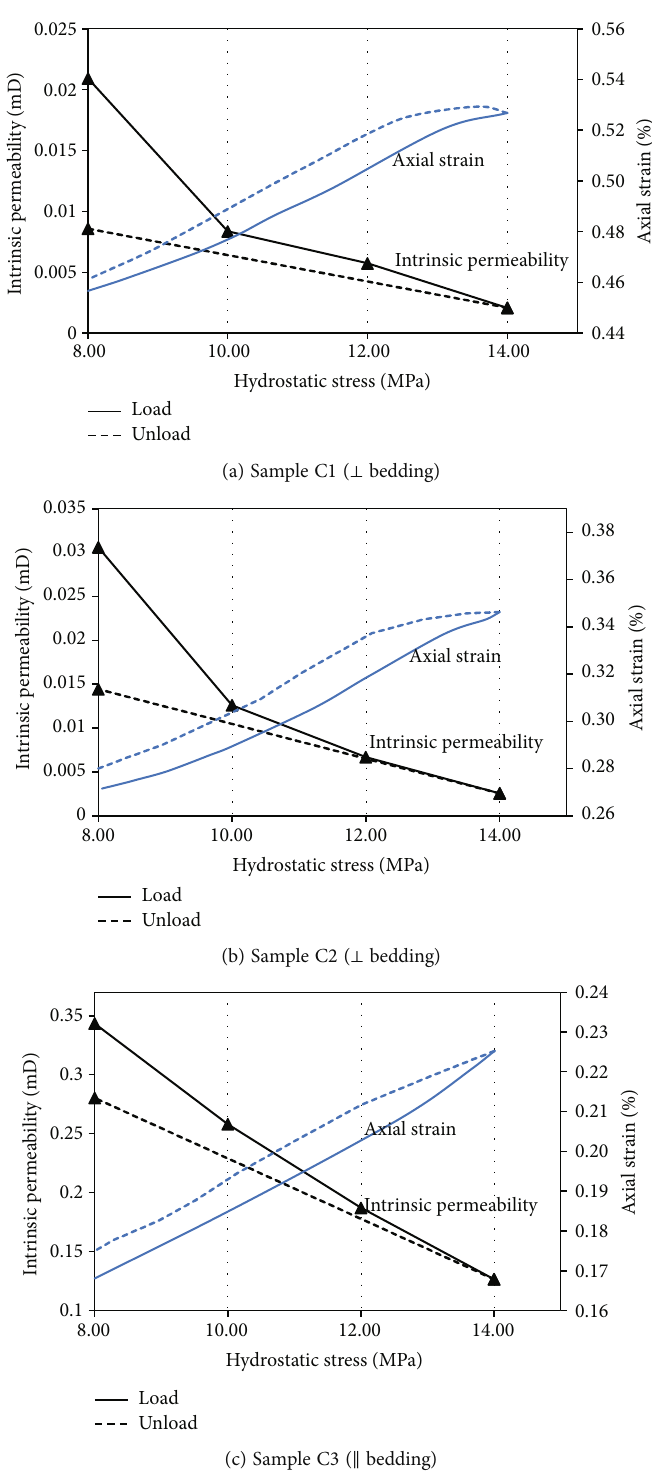
Figure 4: The evolution of intrinsic permeability and axial strain under cyclic hydrostatic